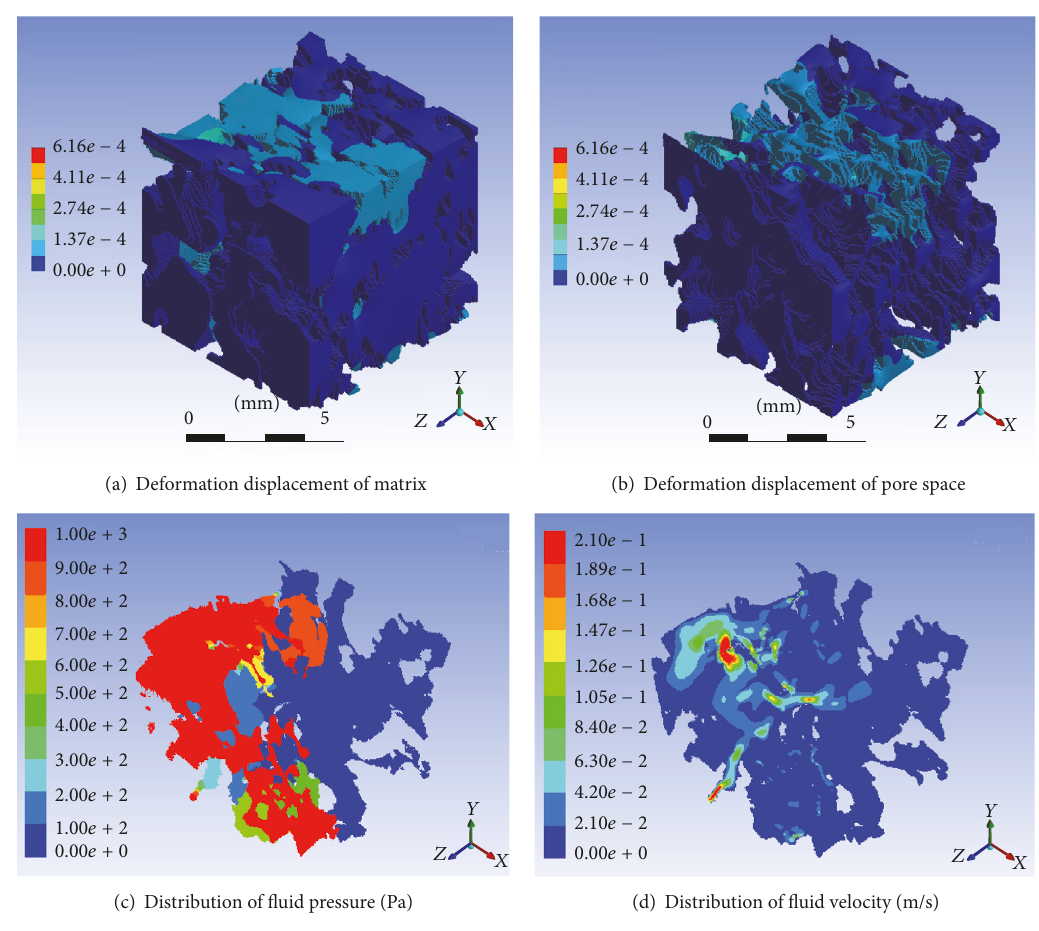
Figure 3: THM simulation of model MS1 under the condition that the confining pressure is 20 MPa and the pore pressure is